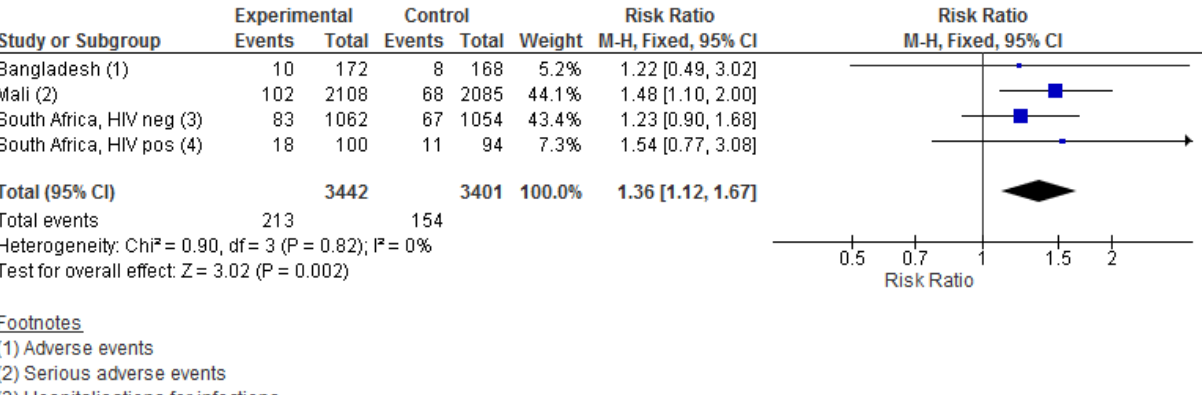
Figure 4. The effect of influenza vaccination in pregnancy on infant non-specific infectious disease adverse events. In Mali and South Africa, infection groups are not mutually exclusive; hence, an ill child could contribute to several groups at the same time. In Mali, the following diagnoses were assumed infectious: neonatal infection; respiratory infection; malaria; meningitis; gastrointestinal infection; unspecified infection; bacteraemia. In South Africa, in HIV-negative cohort, one case